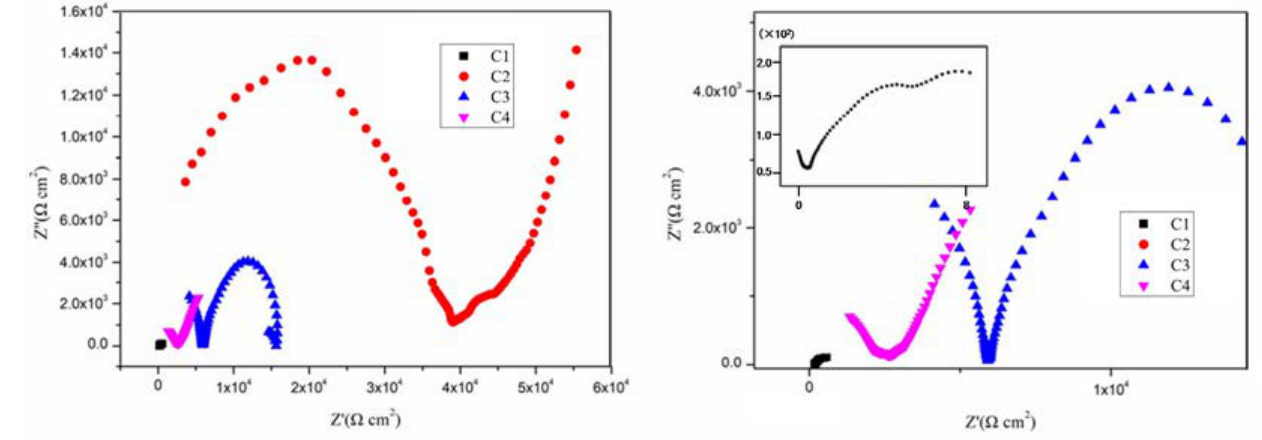
Figure 7. Nyquist plots of coatings after immersion for 31 d: ( a ) Nyquist patterns for 31 d and ( b ) enlarged view of the high frequency of Nyquist